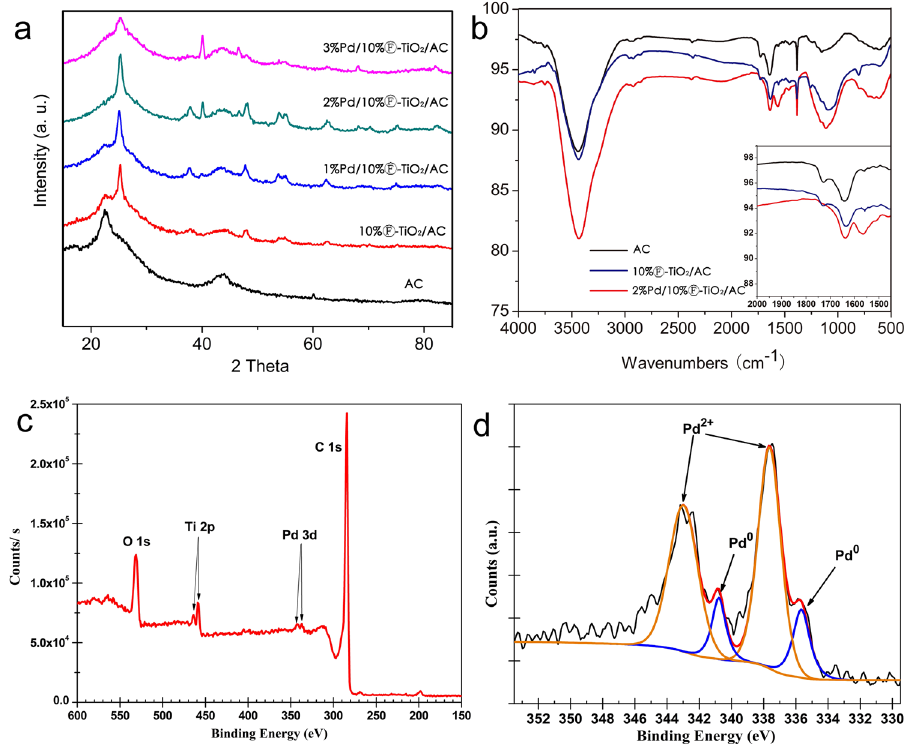
Figure 1. ( a ) XRD patterns of the prepared AC, 10% Ⓕ -TiO 2 /AC, and 1–3%Pd/ Ⓕ -TiO 2 /AC. ( b ) FT-IR spectra of AC, 10% Ⓕ TiO 2 /AC and 2%Pd/10% Ⓕ -TiO 2 /AC. ( c ) XPS scan survey for Pd/ Ⓕ -TiO 2 /AC catalyst. ( d ) Pd 3d XPS spectra of Pd/ Ⓕ -TiO 2 /AC